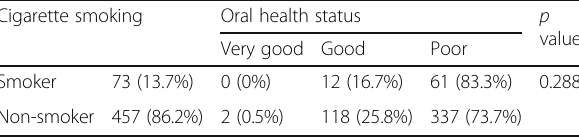
Table 5 Oral health status among smokers and non-smokers